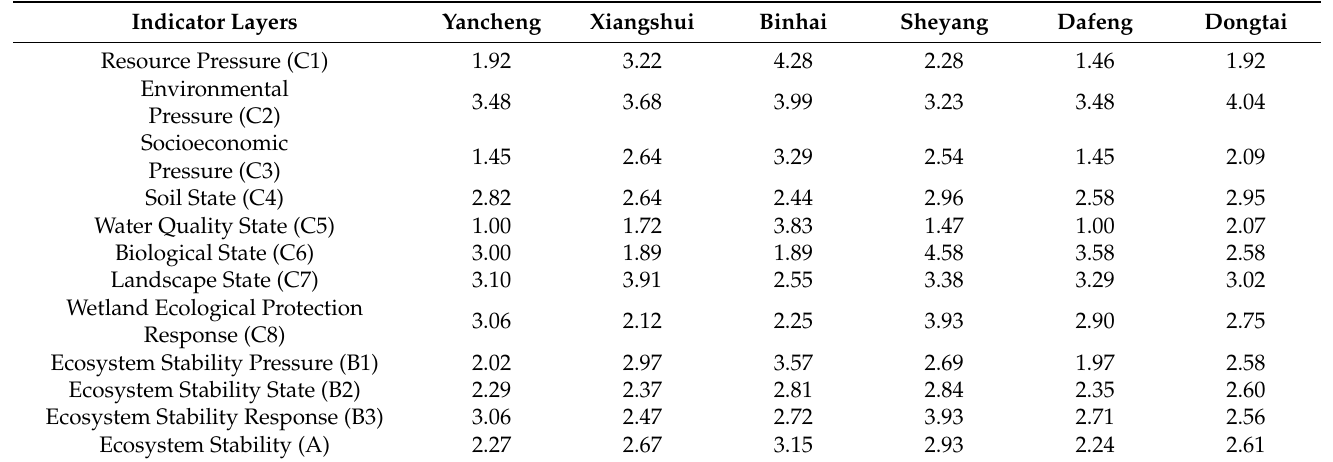
Table 2. Evaluation results of each index layer (A, B,